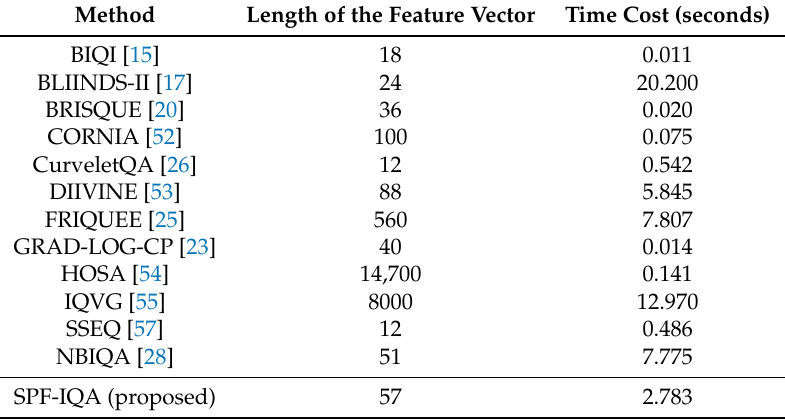
Table 6. Average feature extraction time comparison of learning-based NR-IQA methods measured on KADID-10k